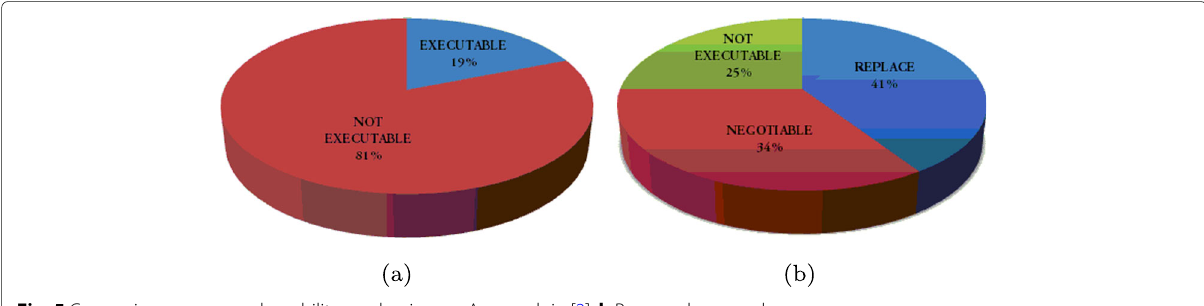
Fig. 5 Comparison among replaceability mechanisms. a Approach in [2]. b Proposed approach